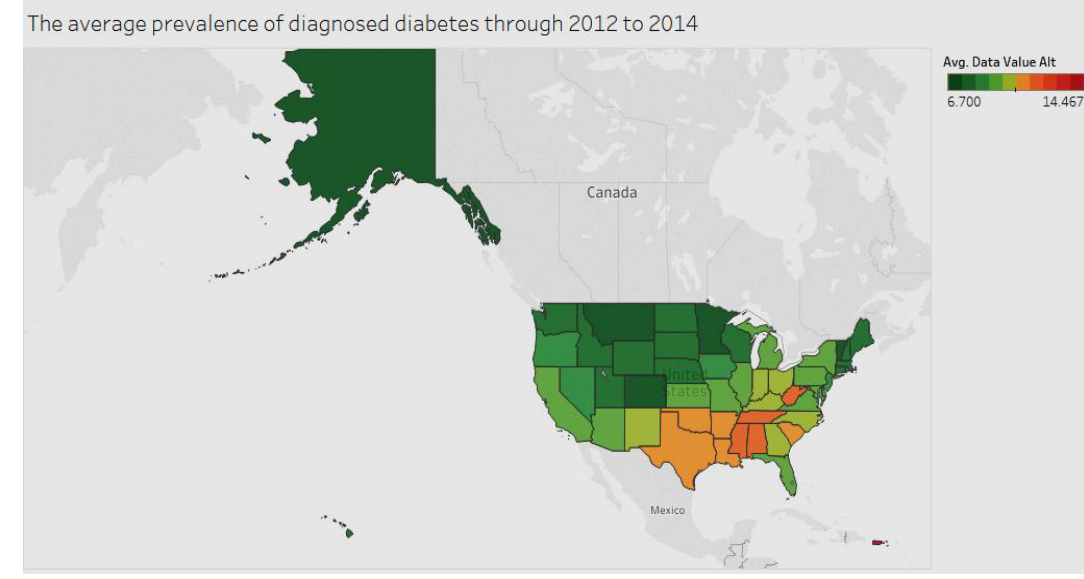
Figure 1 . Diabetes by state. Figure 1. Diabetes by state.